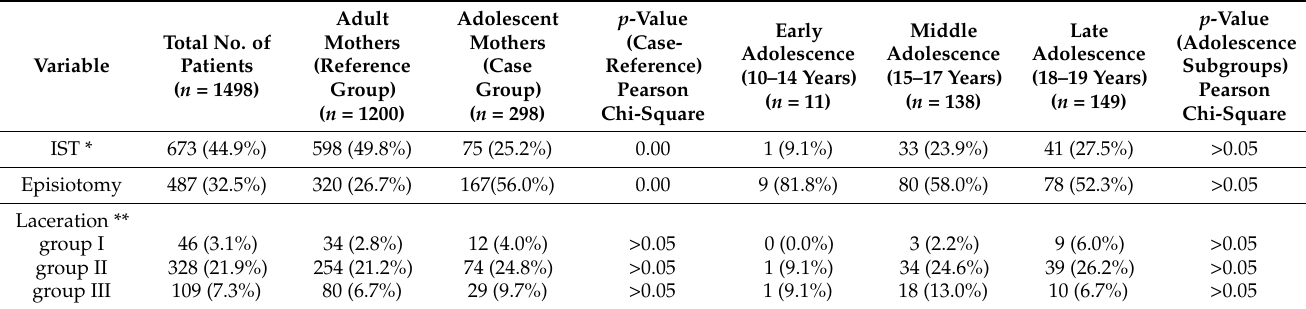
Table 2. Distribution of group lacerations between the study participants according to their age